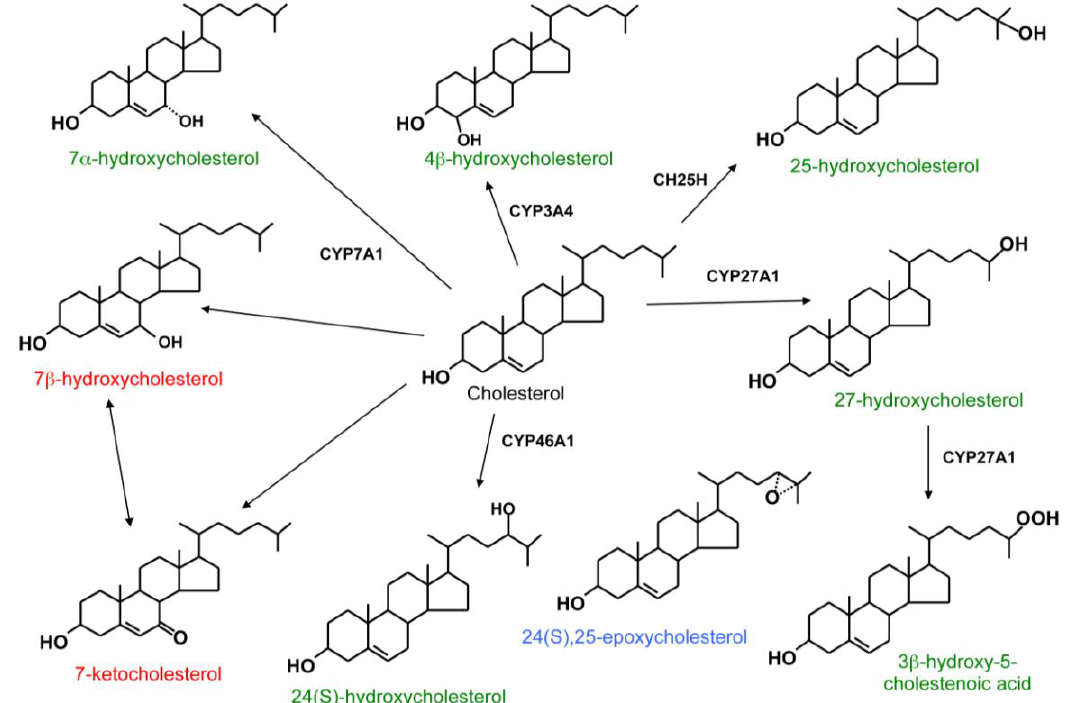
Figure 1. Structure and origin of selected common oxysterols. Most of the oxysterol species displayed are generated by enzymes that belong to the cytochrome P450 family (CYP). CH25H, cholesterol 25-hydroxylase, is a di-iron enzyme. The enzymatically derived species are indicated with green, products of cholesterol autoxidation with red, and a species derived from a shunt of the cholesterol biosynthetic process with blue print (Modified from [2] with kind permission from Springer Science+Business Media